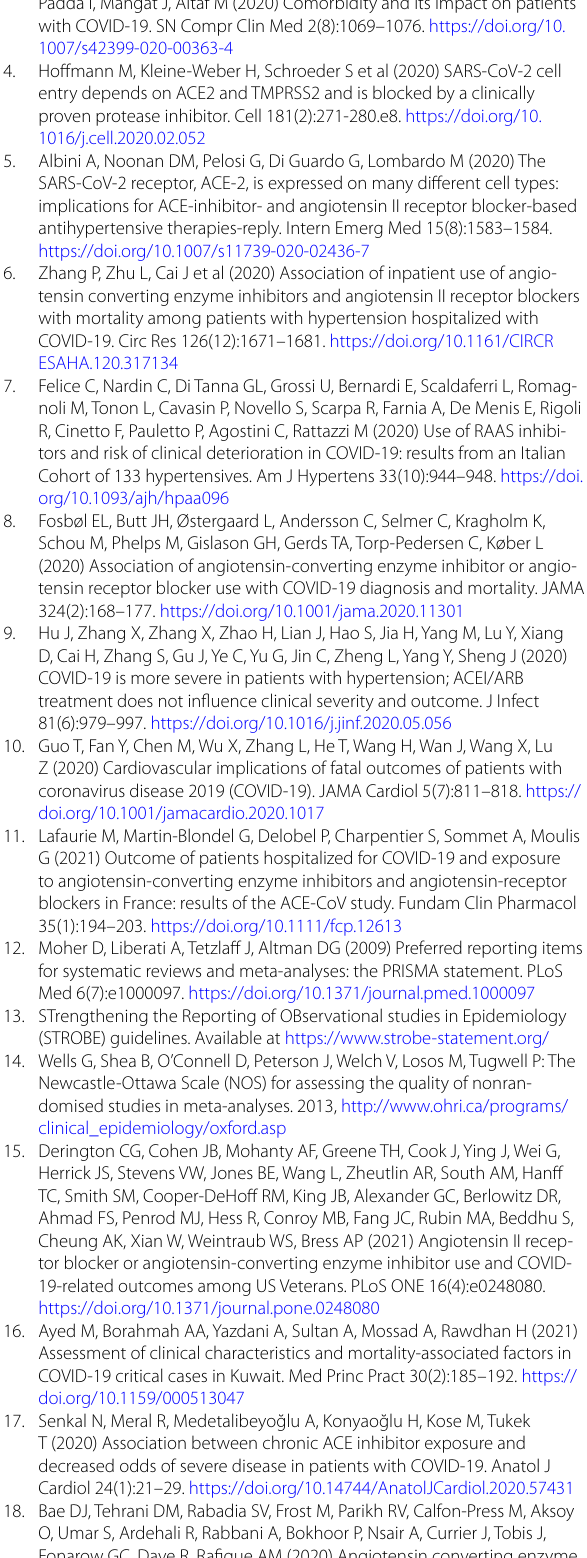
Additional file 1. Table S1: Search Strategy. Table S2: Details of the ACEi therapy (Molecules type). Table S3: Details of the ACEi therapy (Molecules type ramipril). Table S4 Details of the ARB therapy (Molecules type). Table S5: Details of the ARB therapy (Molecules type losartan). Table S6 Details of the ARB therapy (Molecules type